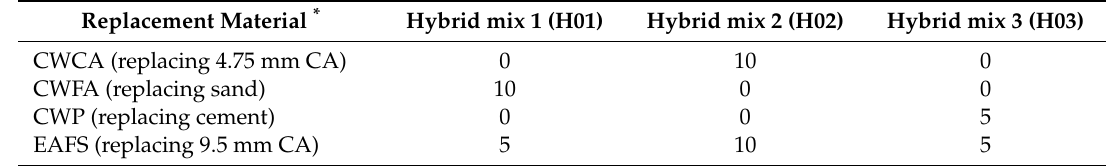
Table 4. Testing matrix for the hybrid mixes used in the study. Replacement Material * Hybrid mix 1 (H01) Hybrid mix 2 (H02) Hybrid mix 3